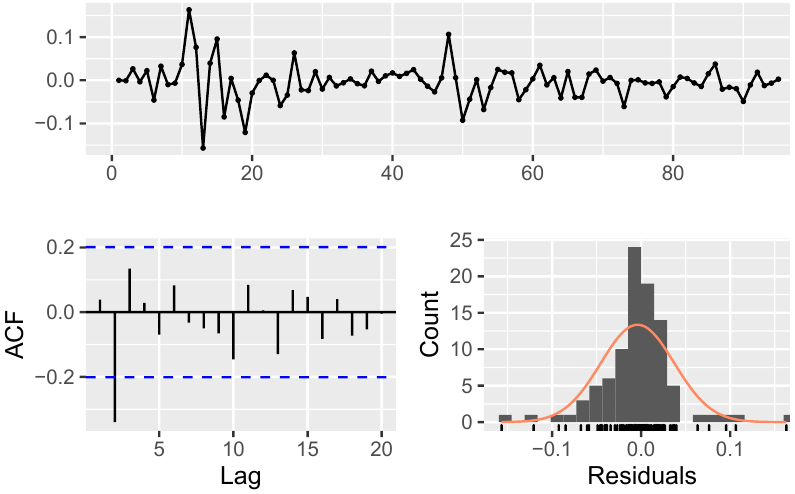
Figure A1. Residuals from ARIMA(1,1,1,) for Stock 1.